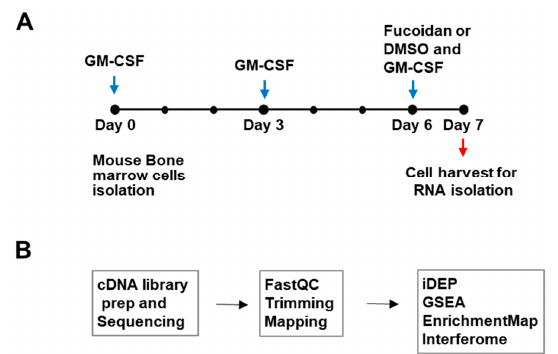
Figure 1. Outline of study design and transcriptome analysis. ( A ) Cell culture scheme. Mouse BMDCs were treated with Fucoidan or control (0.04% DMSO) and subjected to RNA-seq analysis ( B ) Transcriptomic analysis outline: cDNAs were generated, sequenced, and processed. Differentially expressed genes (DEGs) were identified and enriched pathways were analyzed with various bioinformatics tools.